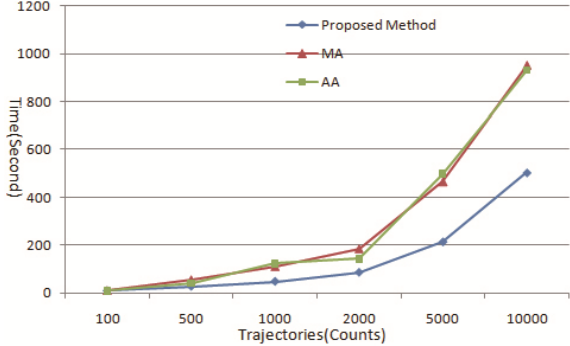
Fig. 7. Time cost of Similarity search